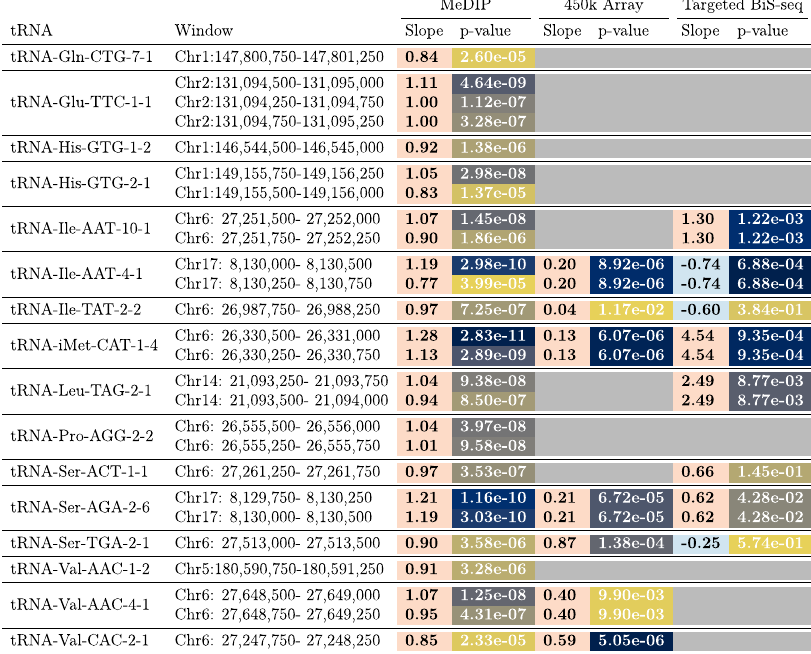
Fig. 1 Ageing-related DNA methylation changes in tRNA loci (16 Study-wide signi fi cant after blood cell-type correction, p < 8.36 × 10 − 5 ). Columns left to right: tRNA gene; Genomic location of MeDIP-seq signi fi cant window (hg19); MeDIP results slope (arbitrary units) and p value; 450k Array results slope (beta) and p value (Blood-cell corrected and combined for all probes overlapping tRNA); Targeted Bisulphite-sequencing (BiS-seq) slope (model beta) and p value (combined all CpGs in targeted region). Units of slope are quantile normalised RPM values or MeDIP-seq models and proportion of CpG sites methylated for the targeted bisul fi te and array based assays, all per unit time. The result for all covered tRNAs are included in the Supplementary data 1, 3, and 4. All p values are for F-tests from simple linear regression. For slope: orange = hypermethylation and blue = hypomethylation with age. For p values: Colour gradient high signi fi cance = dark blue to low signi fi cance = yellow, scaled relative to column. Blank grey cells indicate unavailable